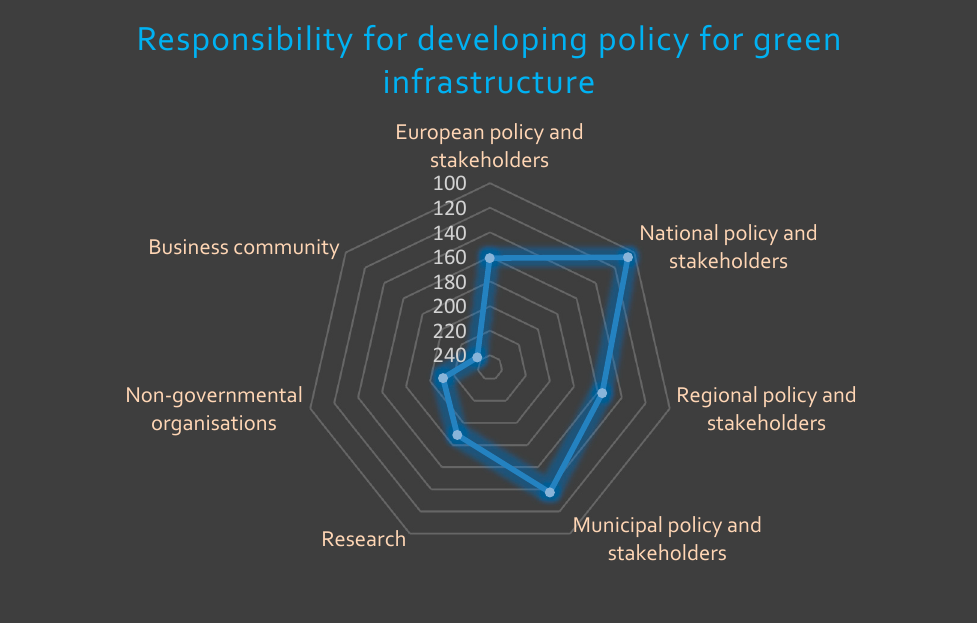
Figure 2. Groups of actors responsible for developing a policy for green infrastructure in the 32 European countries (EU28 and Iceland, Liechtenstein, Norway and Switzerland) based on a summary of 41 online survey responses. The actors/institutions with the lowest score were considered to have the greatest responsibility.